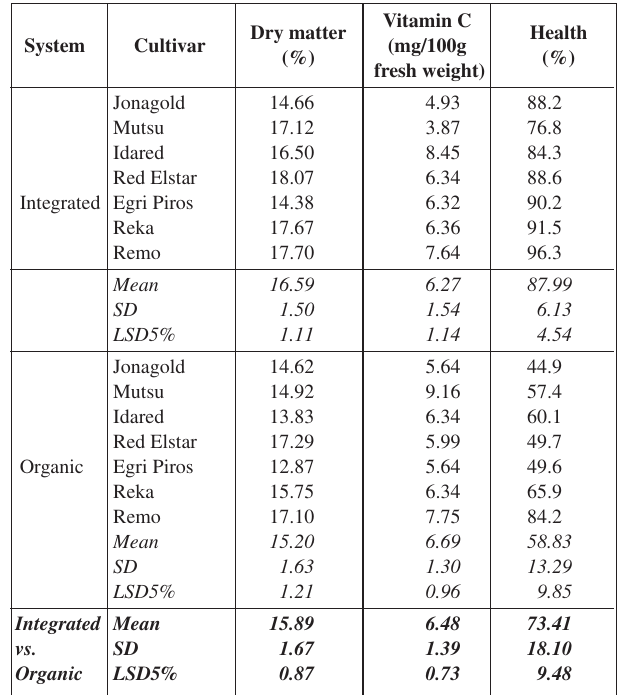
Table 2. Fruit qualifying parameters II. (means of three-year) Vitamin Dry matter